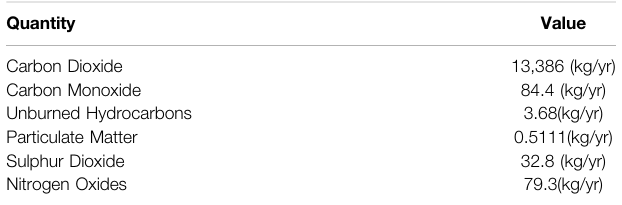
TABLE 13 | Emissions produced by HRES.